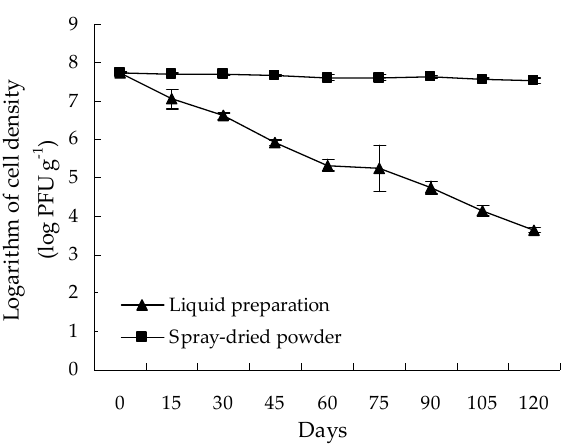
Figure 4. Survival of Bdellovibrio sp. strain F16 in the spray-dried powder and liquid preparation during room temperature storage. Data are presented as the mean ± SD.